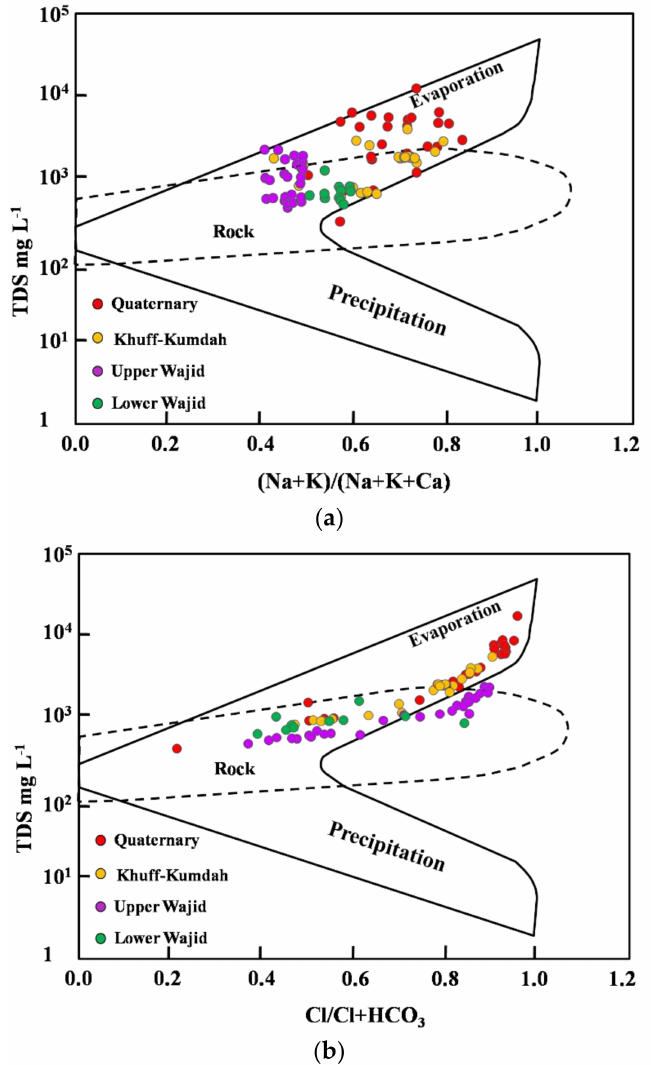
Figure 6. Gibbs diagrams discriminating the dominant processes of groundwater evolution by plotting the TDS (mg L − 1 ) against ( a ) cations (Na + K) / (Na + K + Ca) and ( b ) anions Cl / (Cl + HCO 3